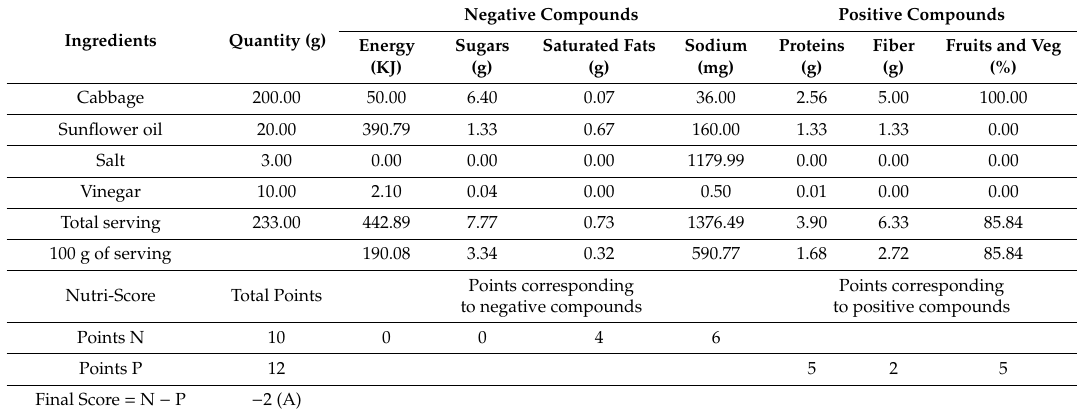
Table A6. Nutri-Score for cabbage salad of the dinner